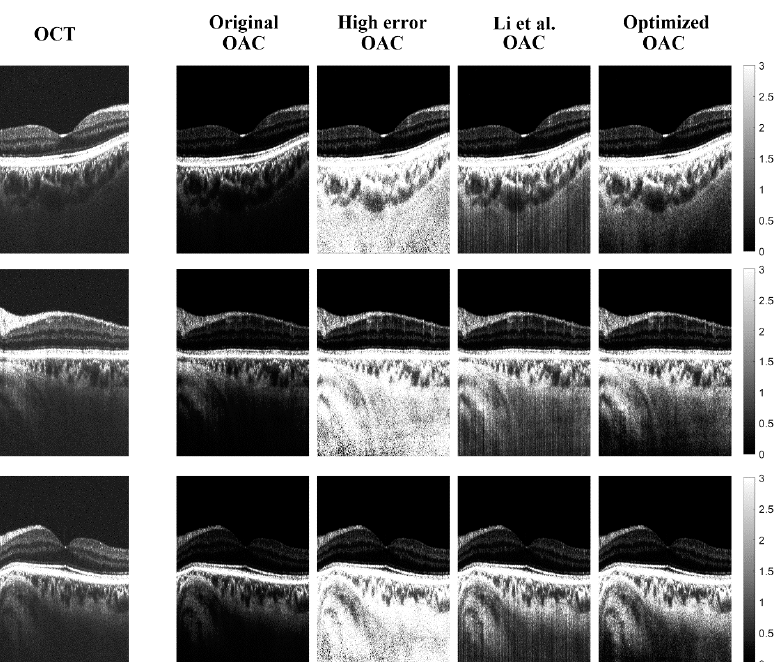
Figure 10. OAC calculation results of human fundus tissues. The unit of the colorbar is mm − 1 .